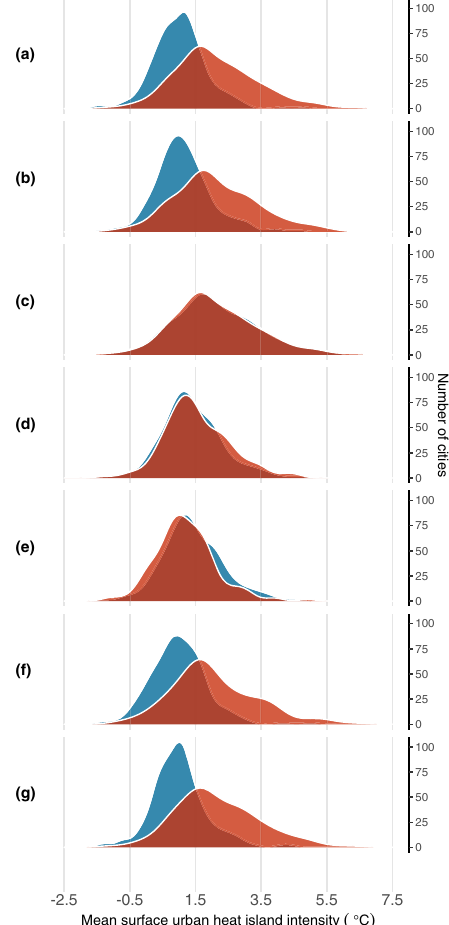
Fig. 1 Distribution across cities of mean summer daytime surface urban heat island (SUHI) intensity by sociodemographic group. Each panel compares kernel density estimates for two sociodemographic groups. Diagrams are normalized so that the area under each curve equals 175 cities. Hispanic is de fi ned as all who report “ Hispanic, Latino, or Spanish origin ” as their ethnicity, regardless of race. People of color includes all Hispanic and all who do not identify as white alone. a Non-Hispanic white vs. all people of color. b 2× above poverty vs. below poverty. c Below poverty vs. all people of color. d Over 5 vs. under 5. e Under 65 vs. over 65. f Over 65: non-Hispanic white vs. all people of color. g Under 5: non- Hispanic white vs. all people of color. a illustrates that people of color have an average SUHI exposure greater than 2 °C in more cities than non- Hispanic